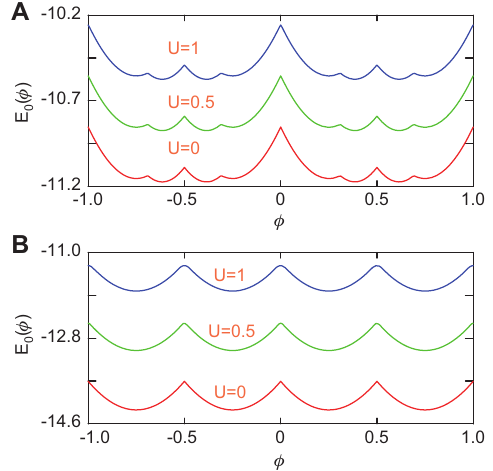
Figure 11 Ground state energy levels as a function of fl ux φ for some perfect cylinders considering N = 8 and M = 2. The red, green, and blue curves correspond to U = 0, 0.5, and 1, respectively. (A) Quarter-fi lled case and (B) Half-fi lled